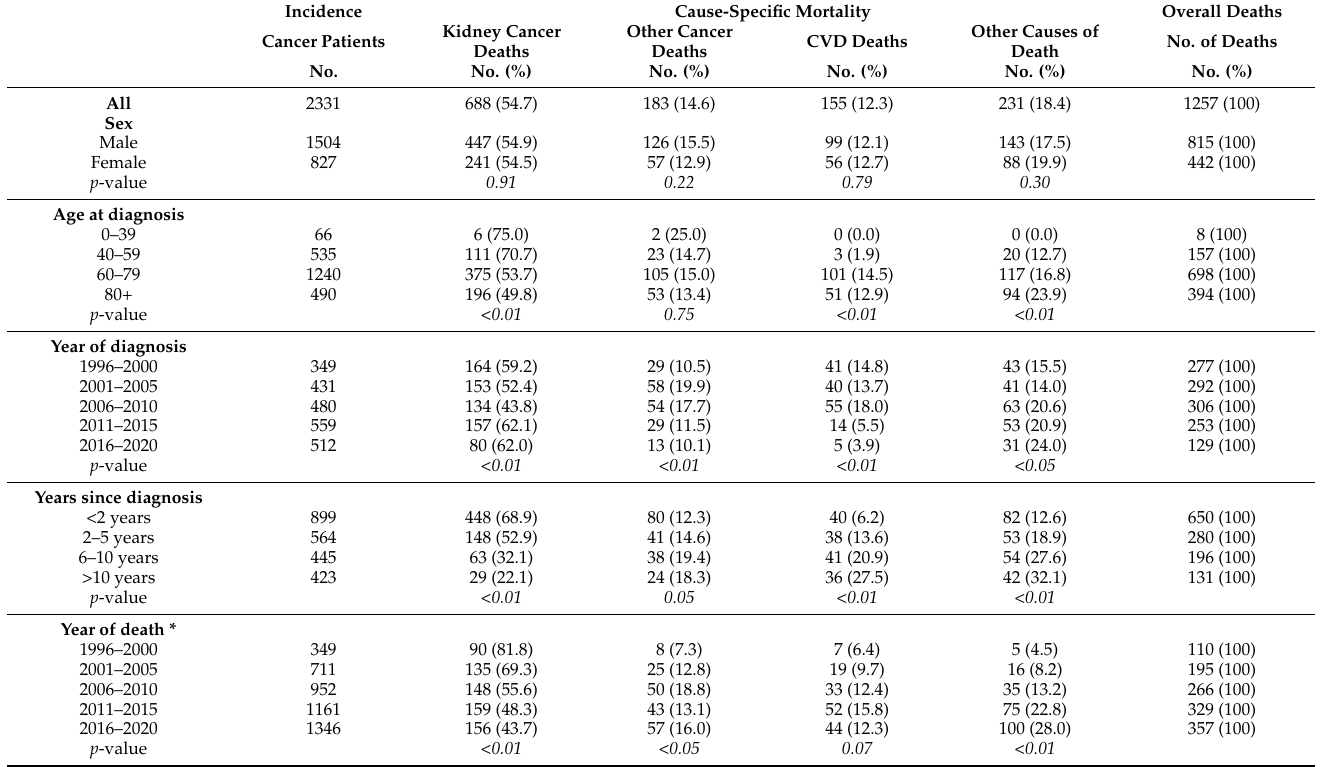
Table 1. Cancer patients and overall and cause-specific mortality in the Province of Reggio Emilia in the period